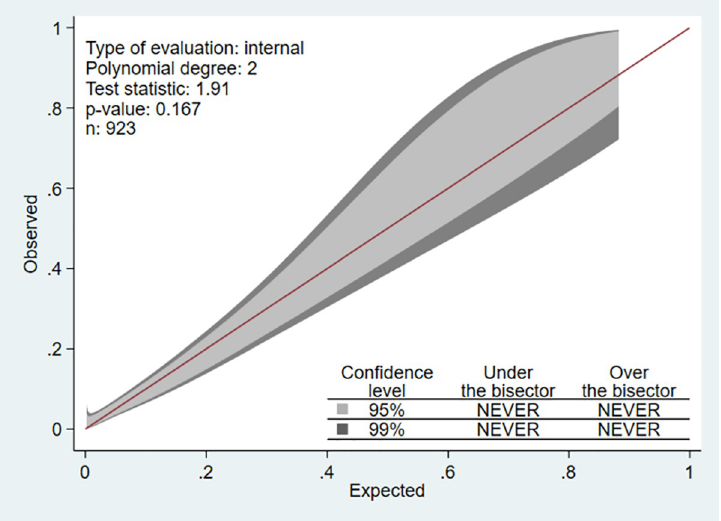
Fig 3. Calibration plot. Visualizing agreement between model predicted and observed proportion of in-hospital mortality in AECOPD